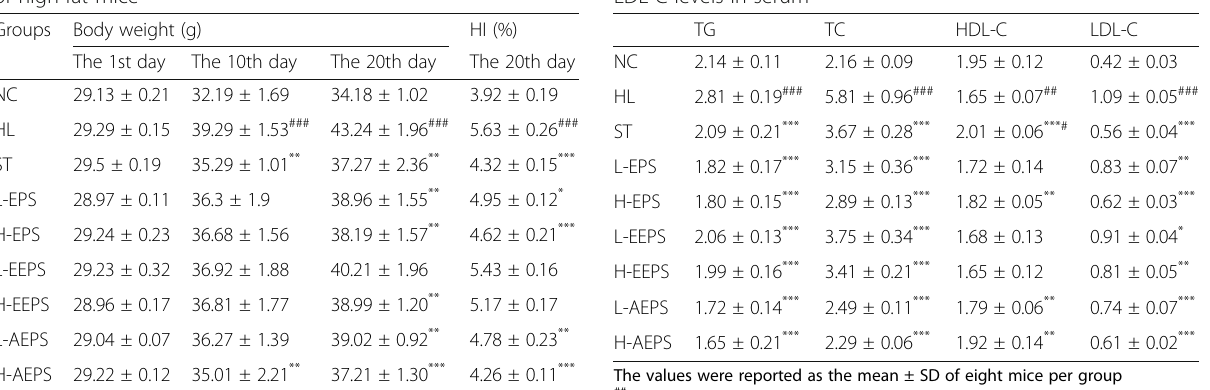
Table 2 Effects of EPS, EEPS and AEPS on TG, TC, HDL-C